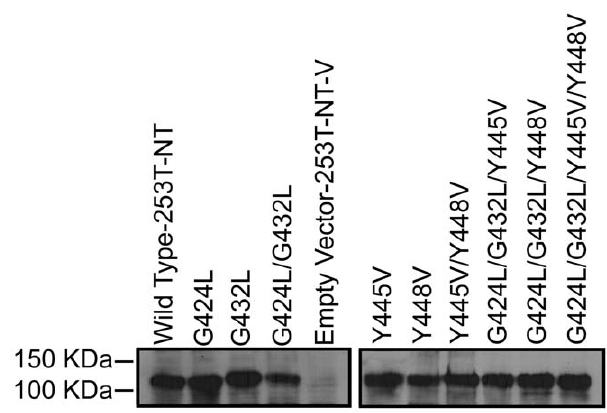
Figure 3. Immunoblot Analysis Shows that Wild Type and Mutant CEACAM1-4S Constructs Have Identical Molecular Mass. Protein lysates prepared from wild type cells and each of the 253T-NT transfected cell lines were resolved on 7.5% SDS-polyacyla- mide gels, transferred onto nitrocellulose and labeled with MAb 9.2 specific to CEACAM1. Analysis of expressed wild type and mutant CEACAM1-4S protein shows that reactive band corresponding to CEACAM1-4S had the same apparent molecular mass (105 kDa).